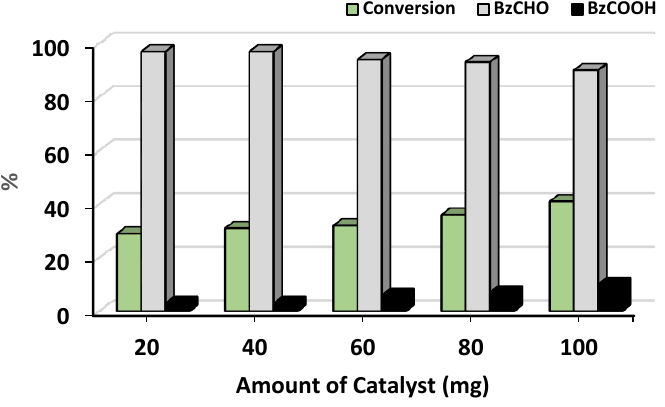
Figure 6. Effect of catalyst amount; conversion is based on benzyl alcohol; benzyl alcohol (100 mmol); TBHP (0.15 mmol); temperature (90 ◦ C); O 2 balloon 1 atm; time (24 h); BzCHO—Benzaldehyde; BzCOOH—Benzoic acid.